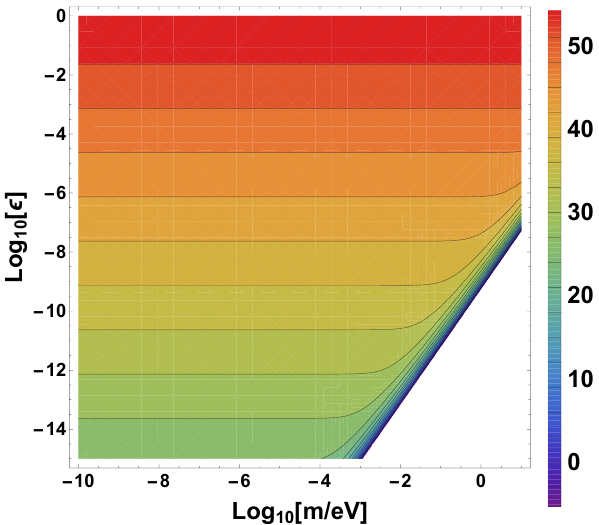
Figure 3 . Pair production rates for light millicharged fermions in a representative polar gap electric (cid:12)eld of 10 14 Vm (cid:0) 1 . The rates per unit volume are in units of m (cid:0) 3 s (cid:0) 1 . The typical rates in most of the parameter space of interest are many orders of magnitude larger than the corresponding e + (cid:0) e (cid:0) rate at these (cid:12)eld values. The latter requires (cid:12)elds close to a critical value of 10 18 Vm (cid:0) 1 , for Schwinger pair production to be